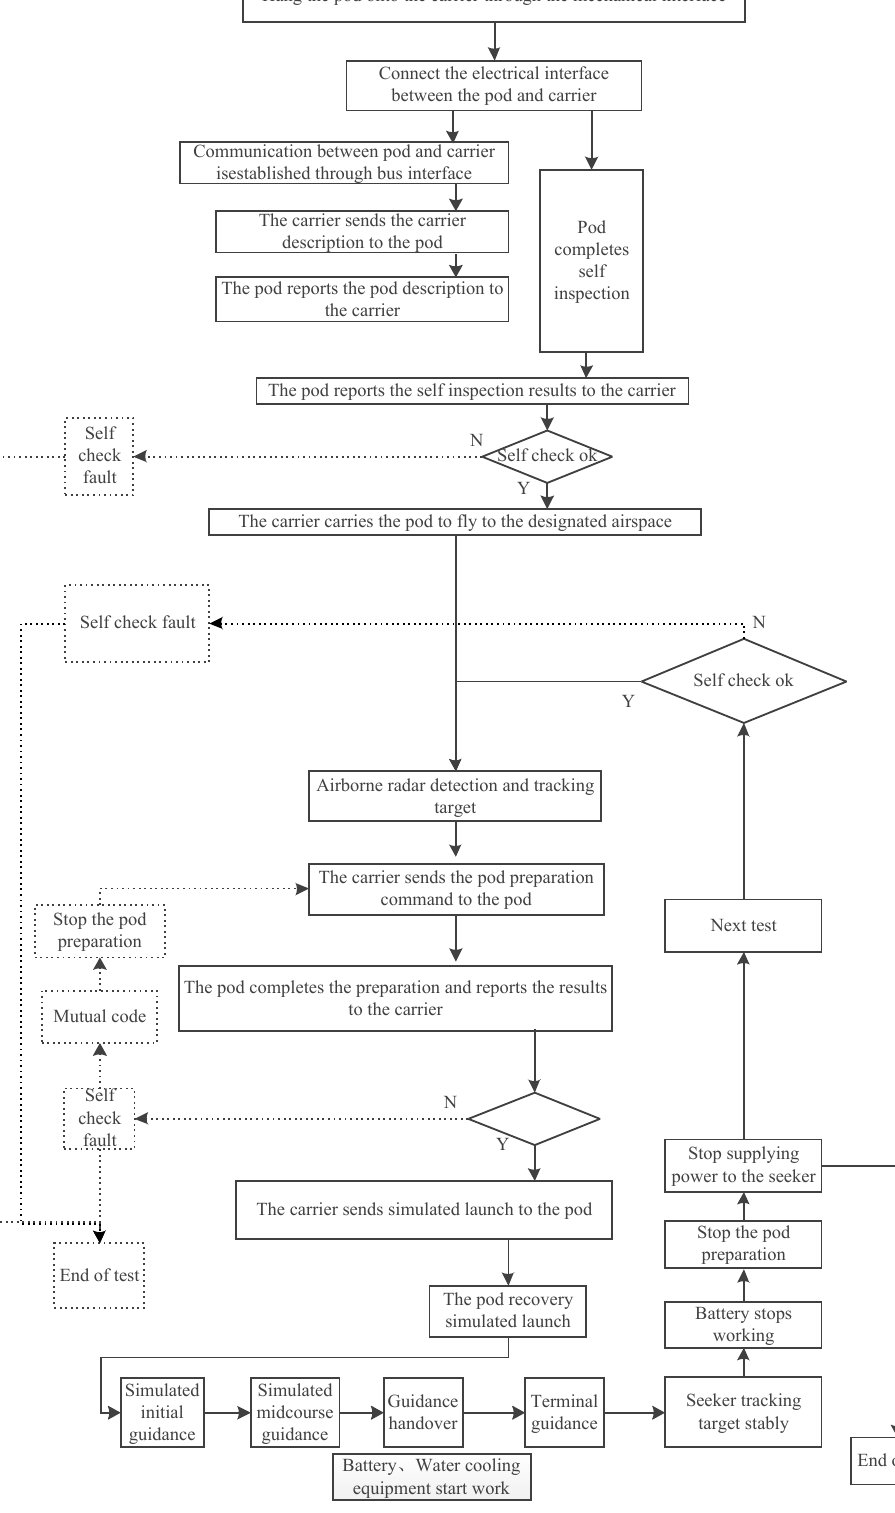
Figure 8. Time sequence of the workflow.